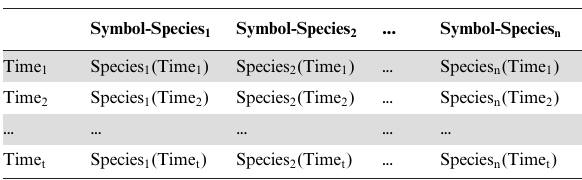
Table 1. Time course data file example.